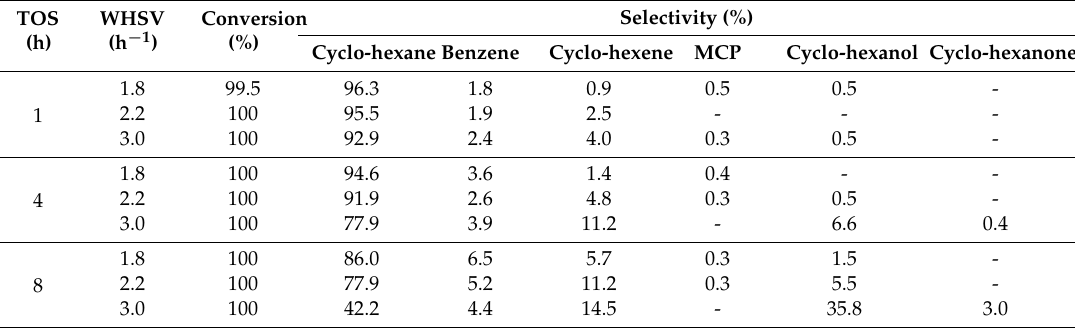
Table 5. Effect of WHSV on phenol HDO over 10Ni10Co/HZSM-5 in the flow reactor. TOS